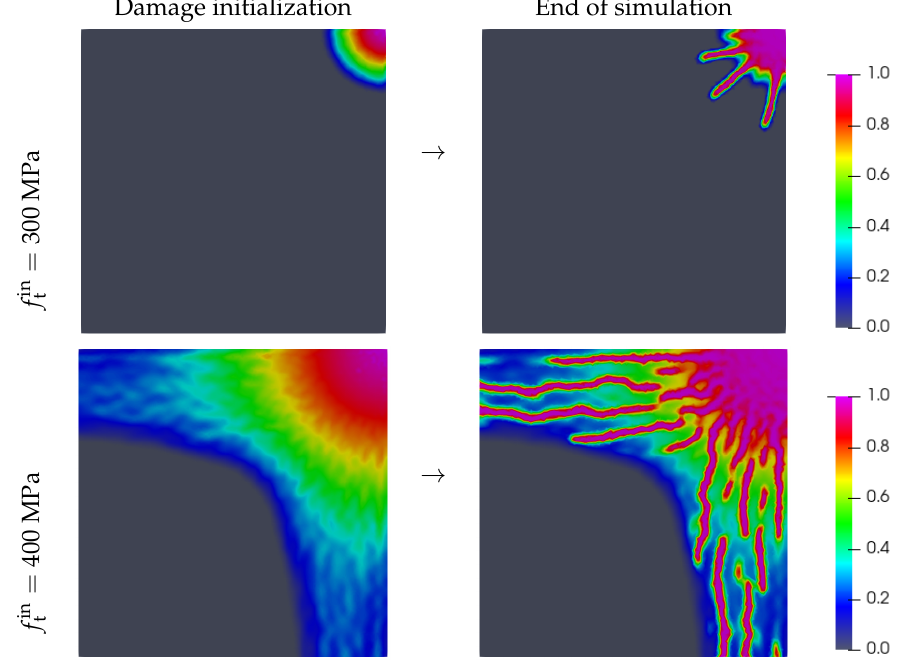
Figure 13. Damage evolution in back glass layer of 5LG laminate for two values of initial tensile strength f in t .